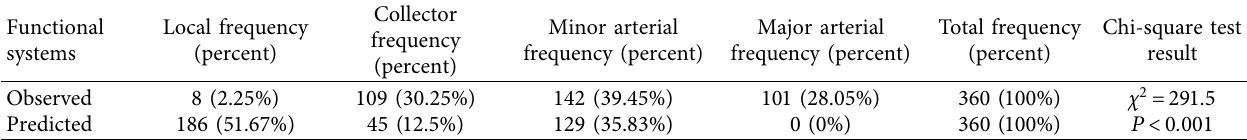
Table 7: Chi-square test based on design speed.